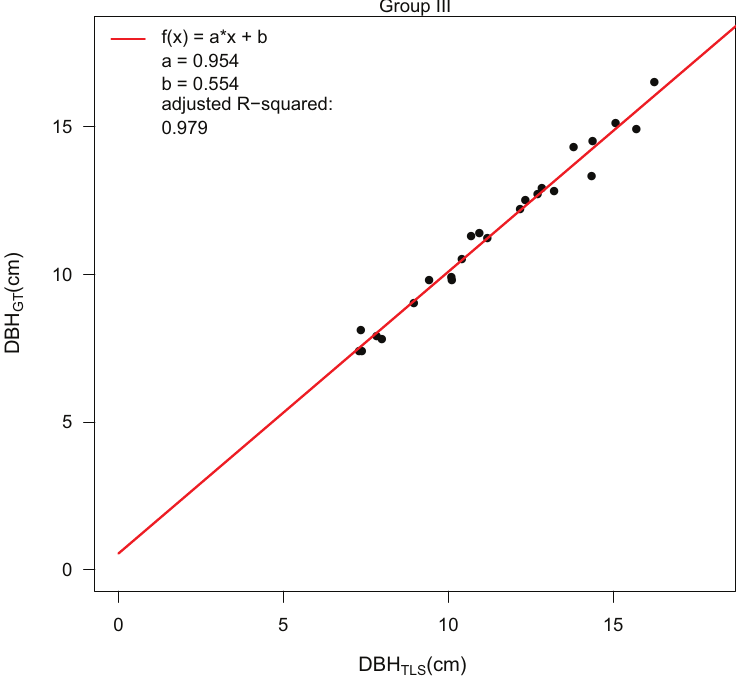
Figure 11. Validation of TLS-derived and manually-measured DBH